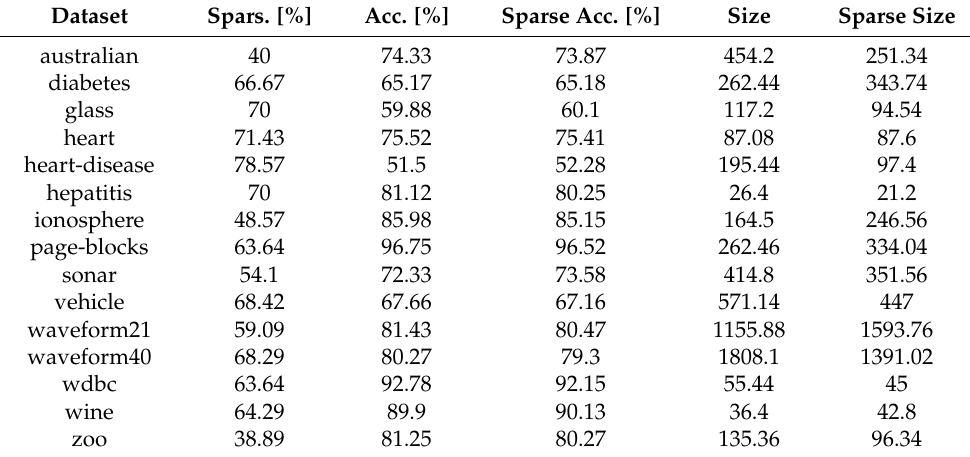
Table 2. Sparse DT predictive model characteristics.